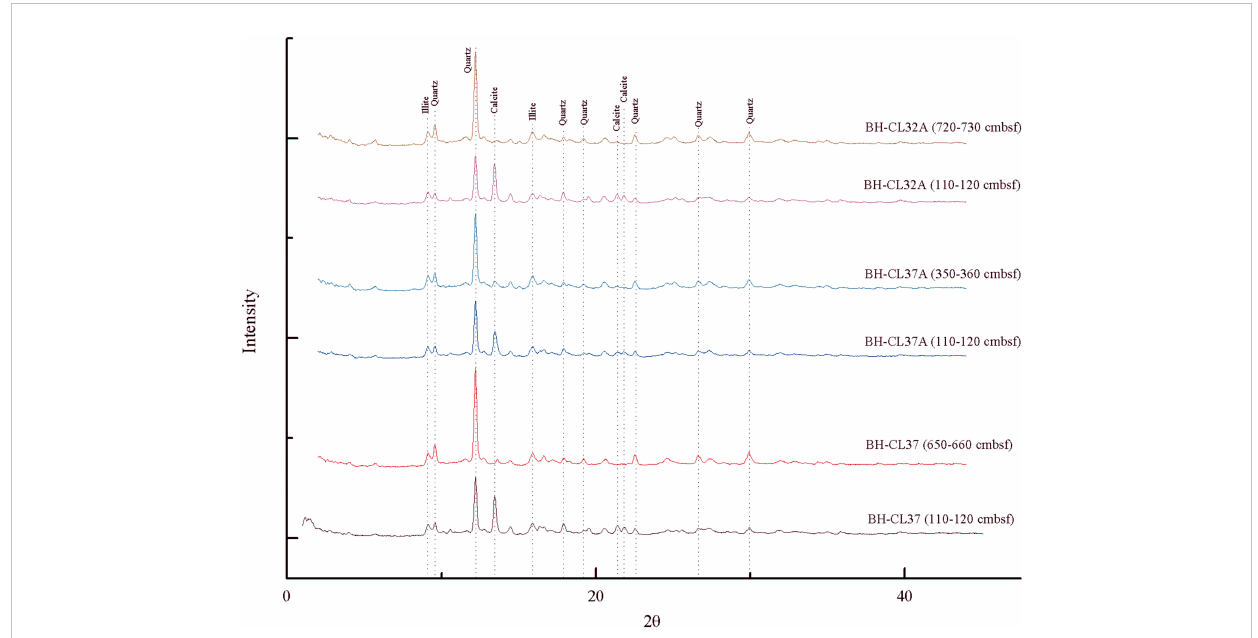
FIGURE 6 XRD results of the studied sediment cores. Shallow sediments show higher contents of calcite in each sediment core.